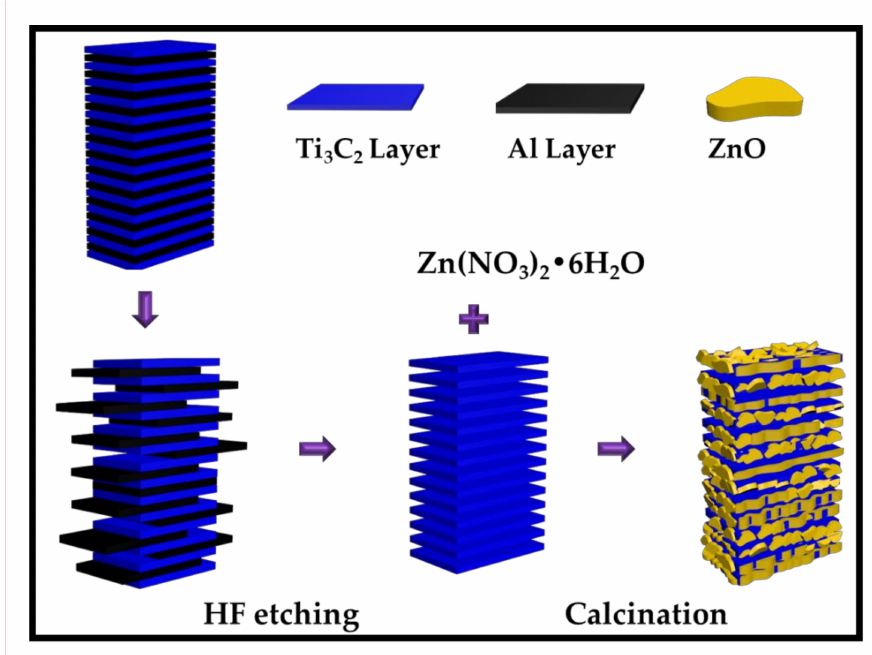
Figure 9. Schematic illustration of the synthesis process of ZnO / Ti 3 C 2 T x hybrid